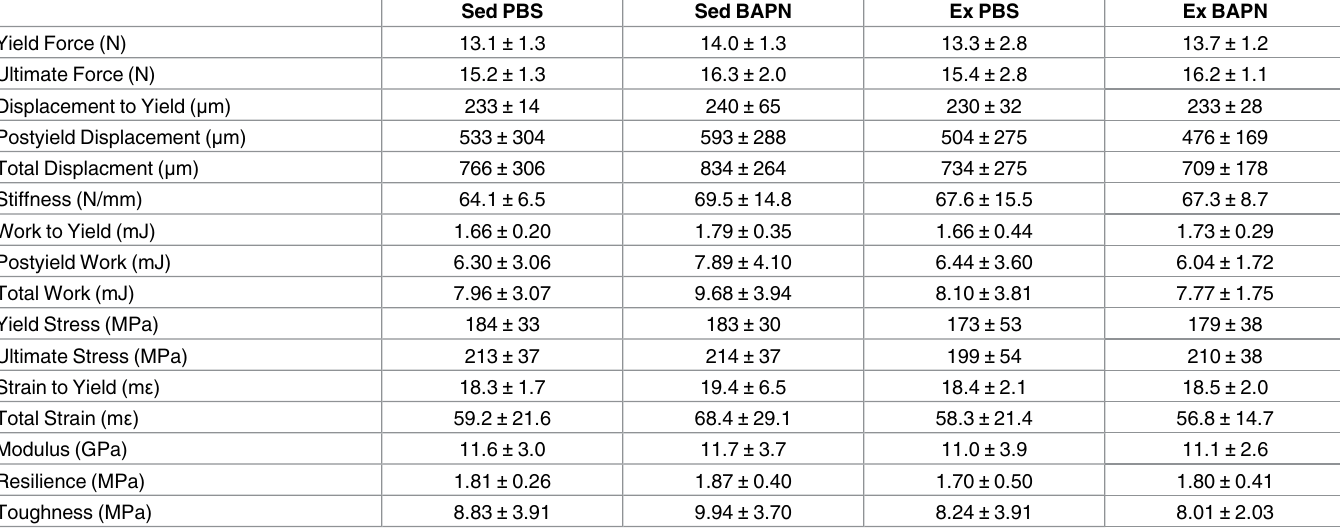
Table 7. Structure- and tissue-level mechanical properties from 4 point bending of left